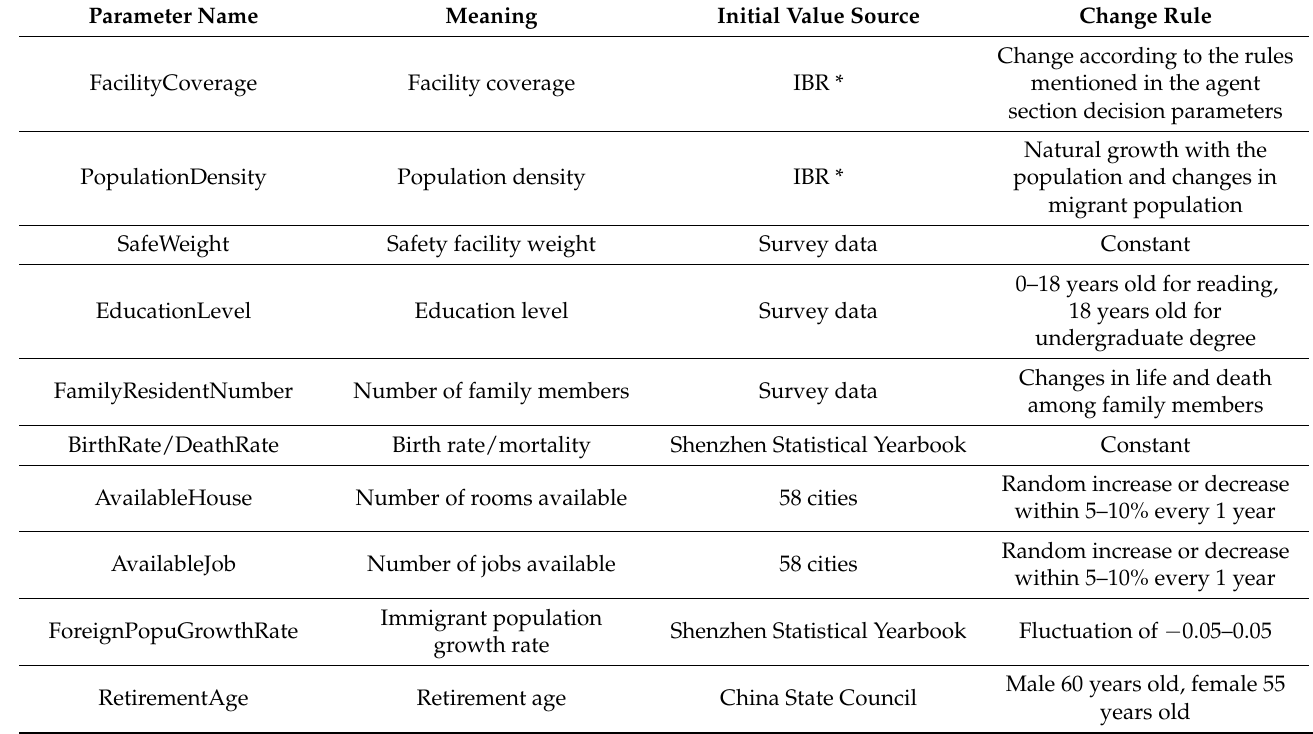
Table 1. Main parameters of the